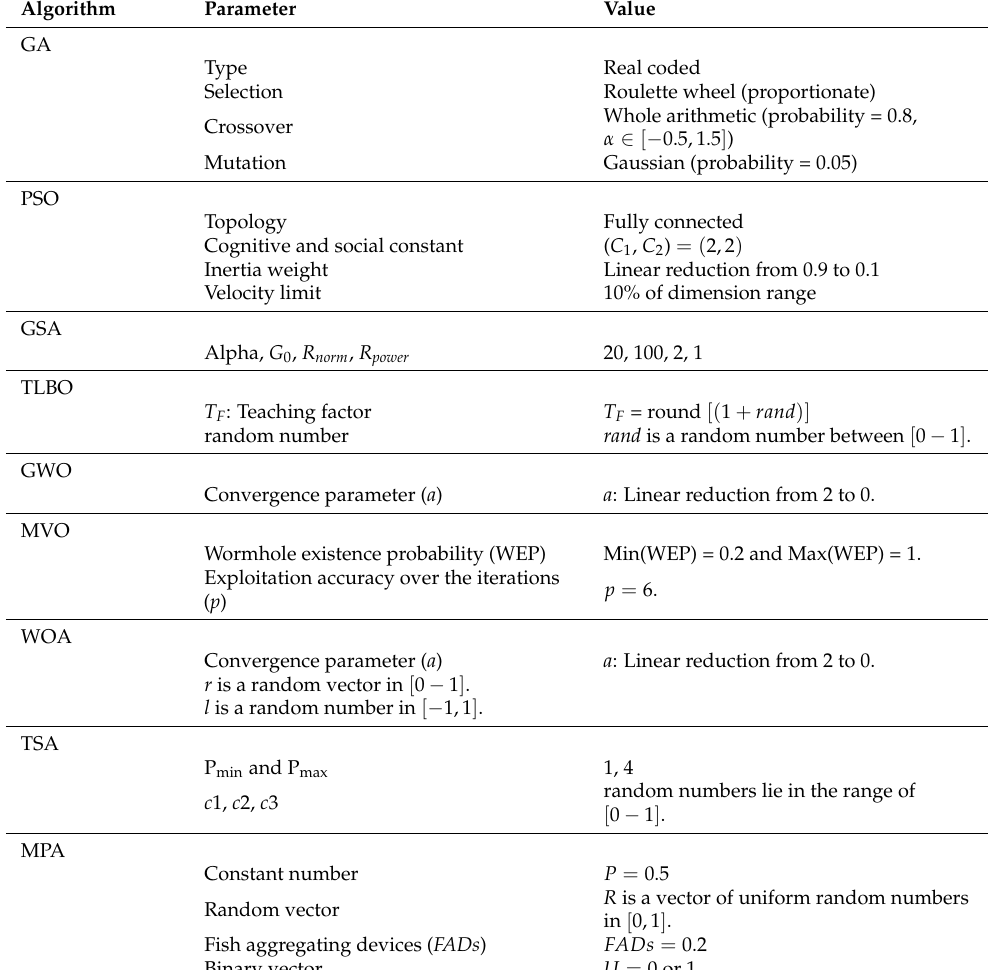
Table 1. Control parameters